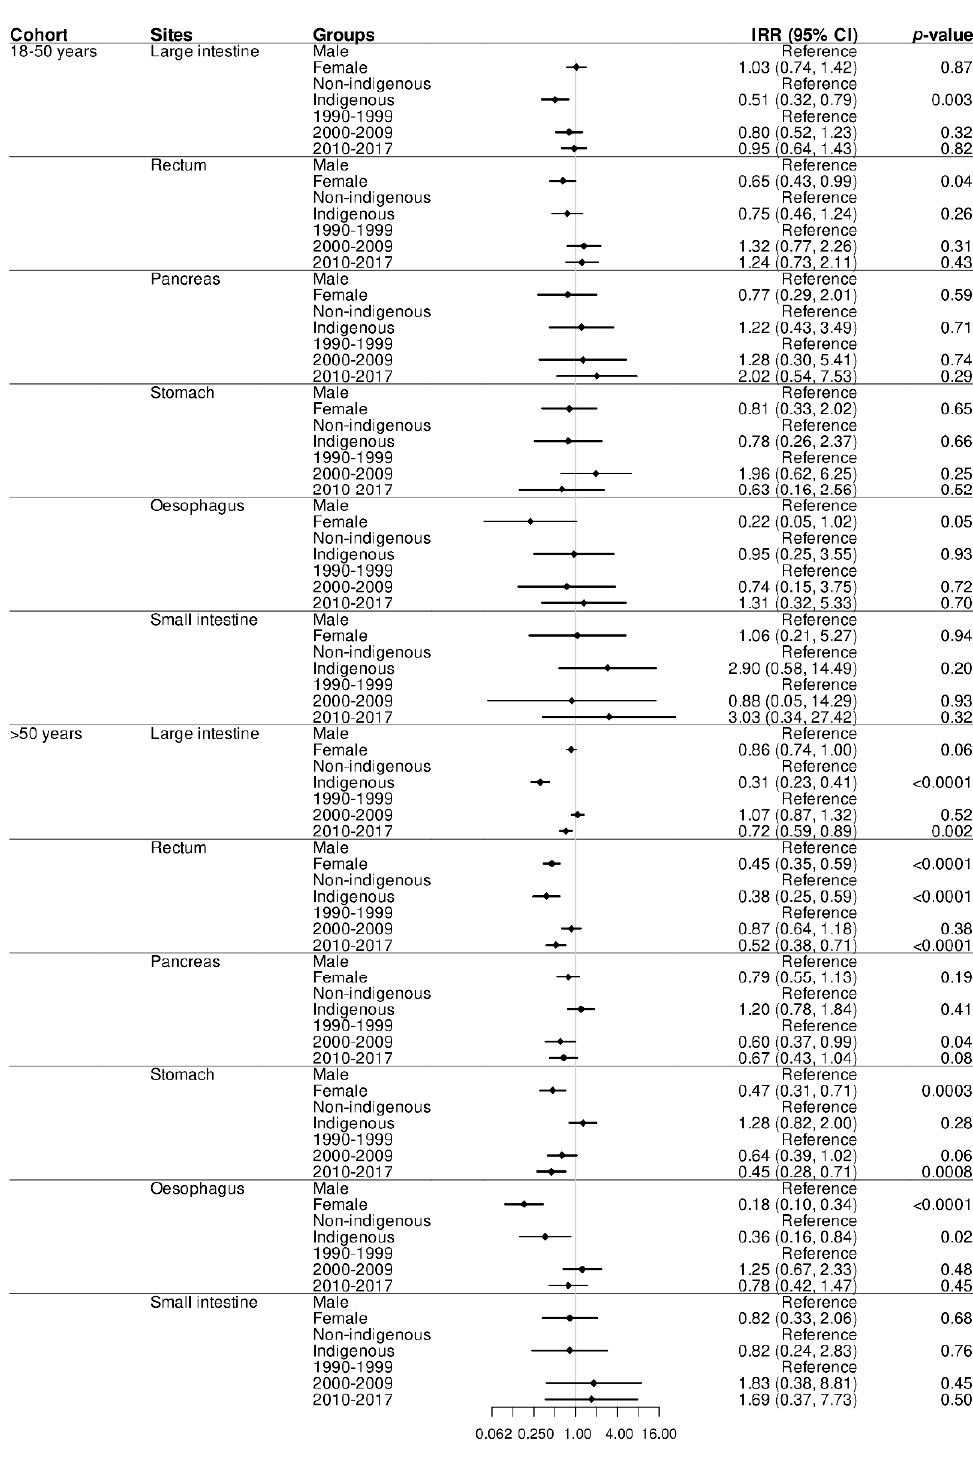
Figure 3. Incidence rate ratios (IRR) and 95% CI (Poisson regression model) for Indigenous status, sex, and era by primary sites between two age groups ( n =